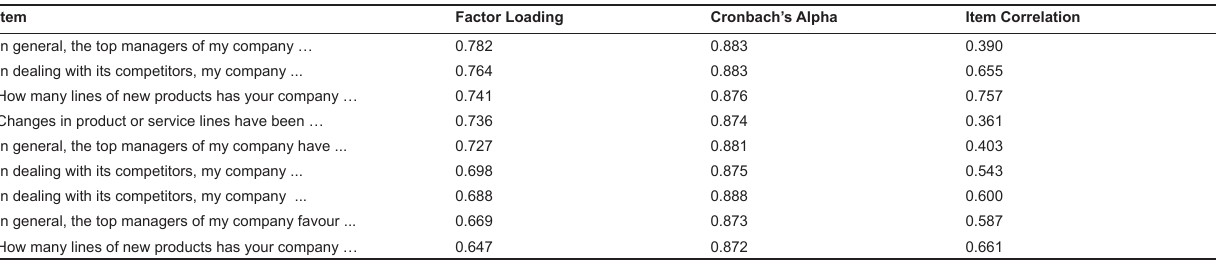
TABLE 4 Factor Matrix for EO scale: Reliability and